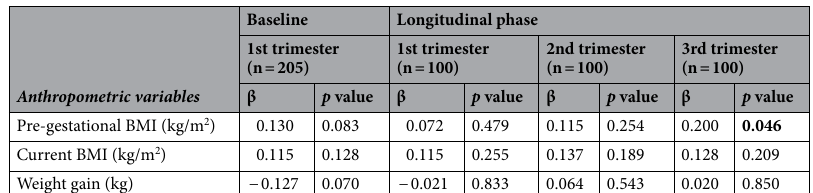
Baseline Longitudinal phase 1st trimester (n = 205)